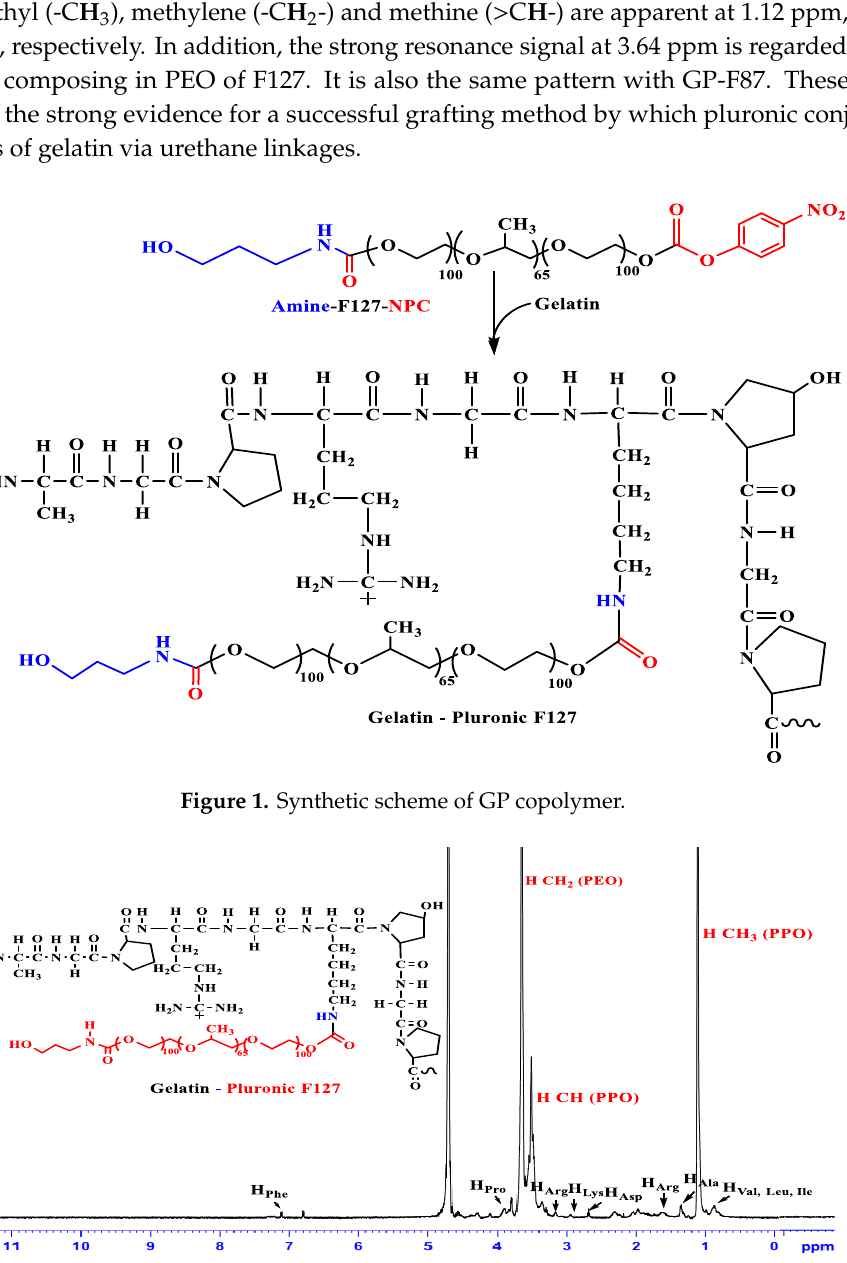
Figure 2. 1 H NMR spectrum of pluronic F127-grafted gelatin copolymer in D 2 O .